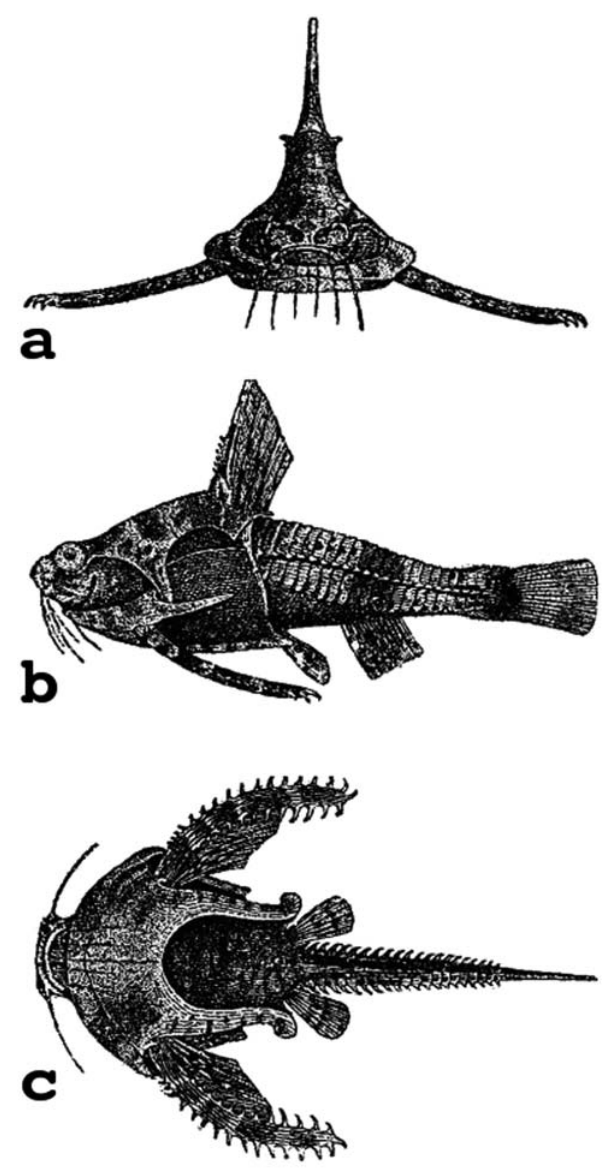
Fig. 1. Physopyxis lyra. Ilustration from original description by Cope (1872). a. anterior view; b. lateral view; c. ventral